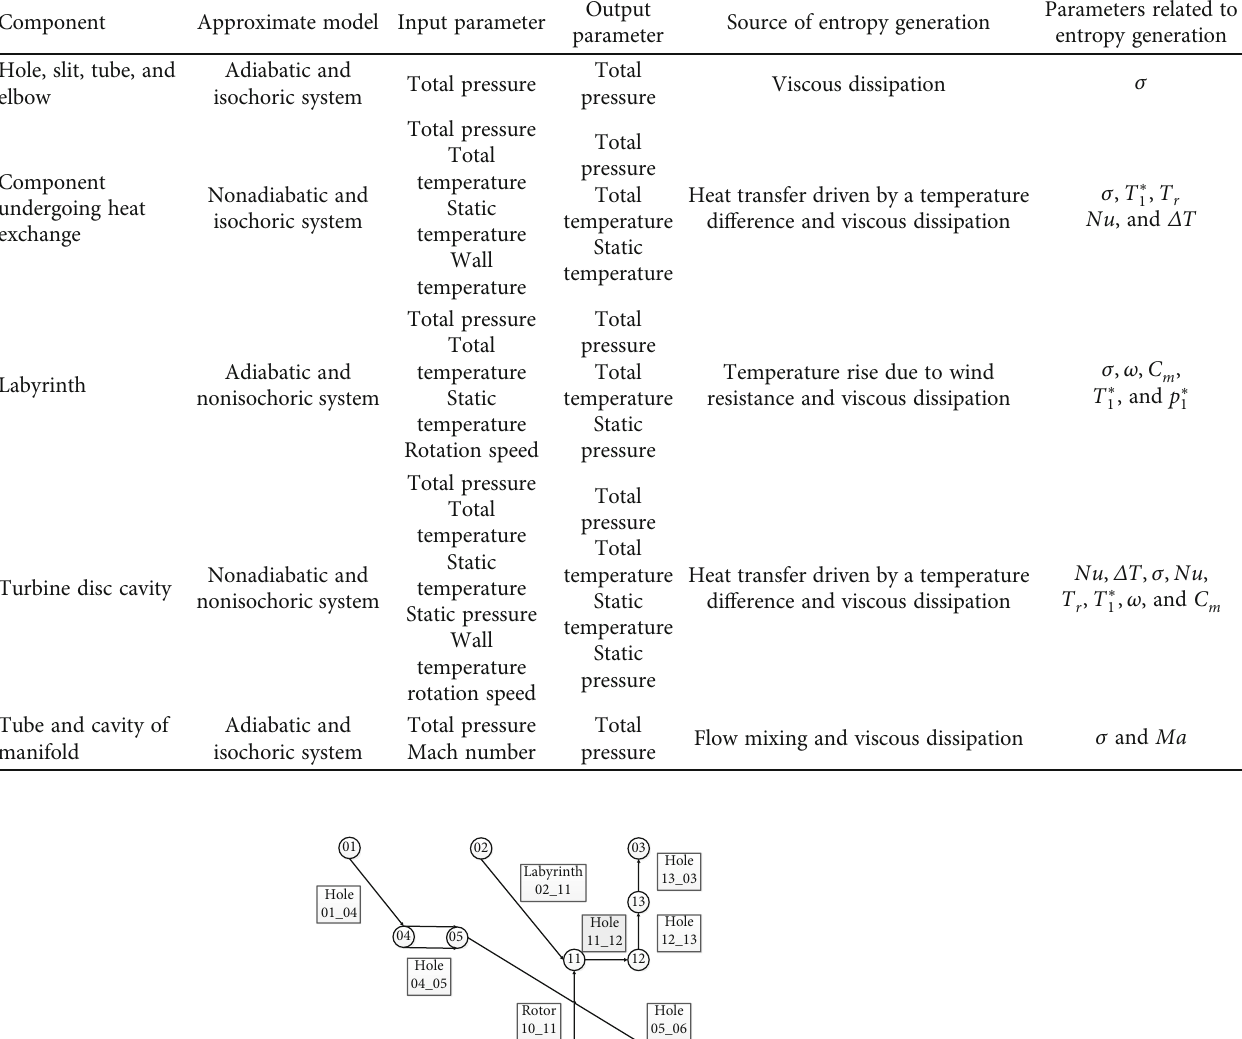
Table 1: Sources of entropy generation and parameters related to the components of the air system. Component